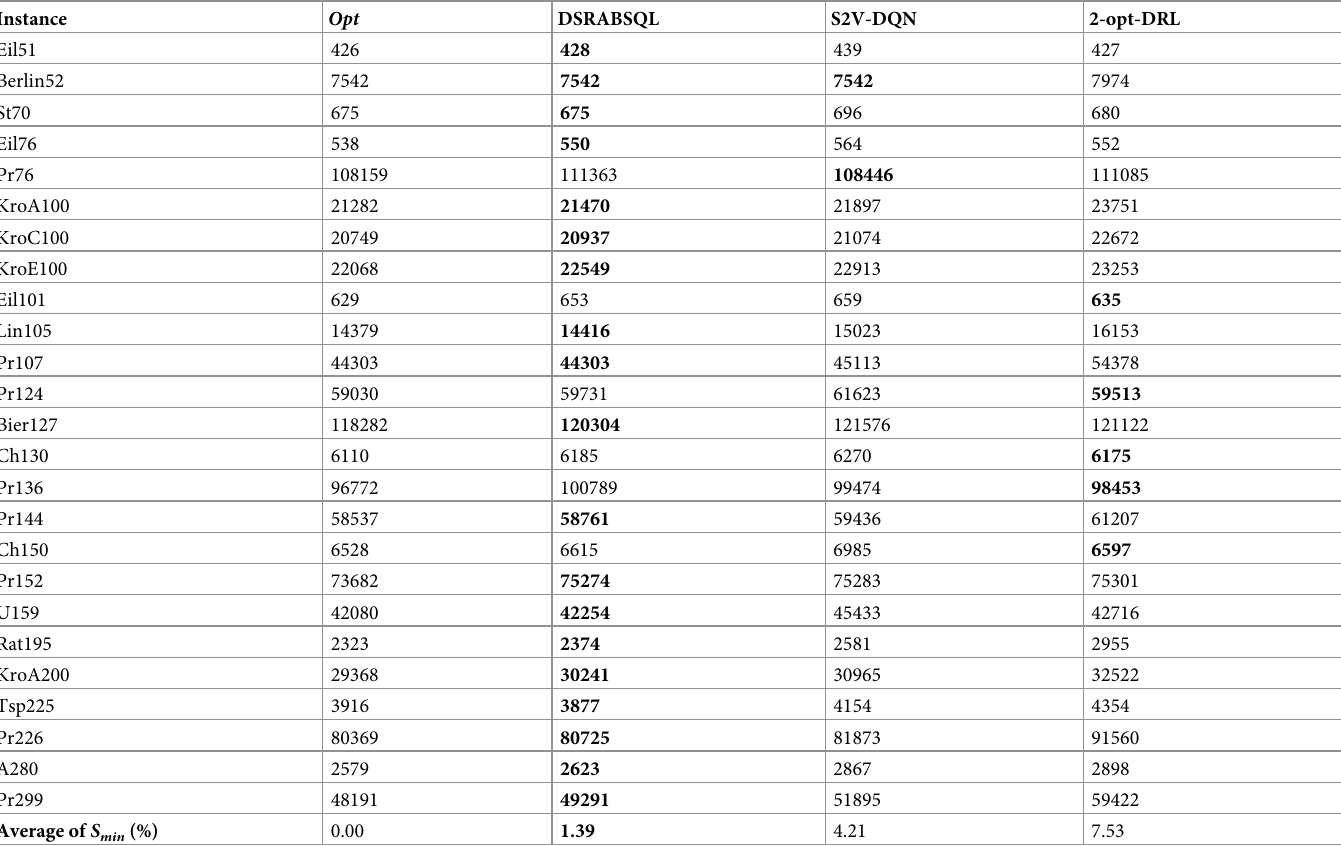
Table 9. The min obtained by DSRABSQL, S2V-DQN and 2-opt-DRL algorithms for 25 instances.